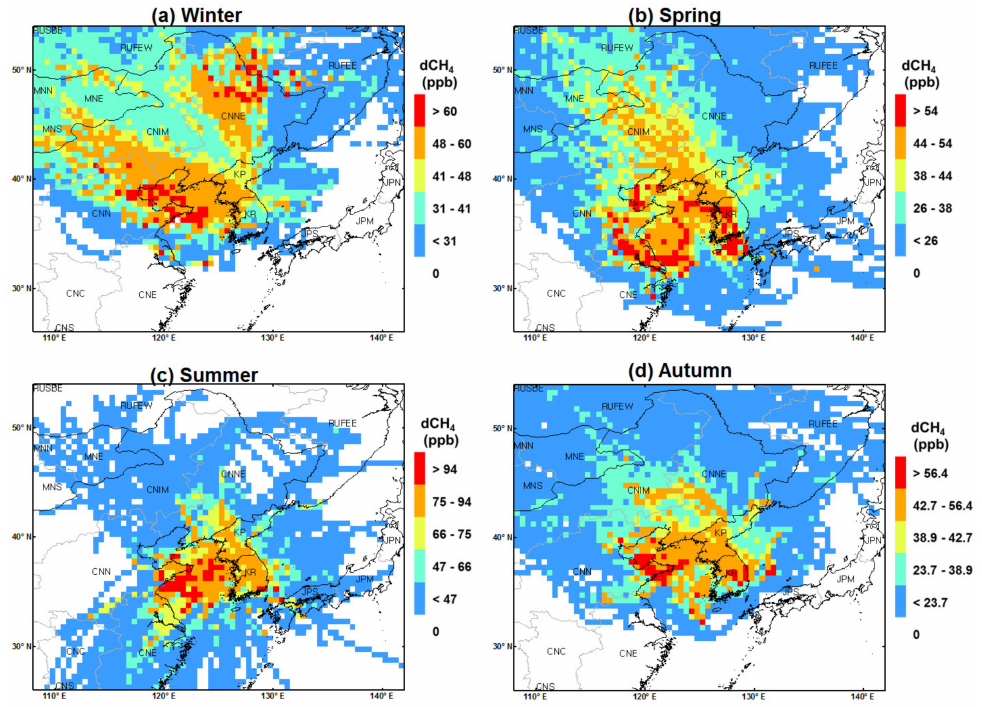
Figure 8. CH 4 source distribution map derived by CWT analysis for ( a ) winter, ( b ) spring, ( c ) summer, and ( d ) autumn. Each gridded map value denotes the trajectory residence time weighted average of the dCH 4